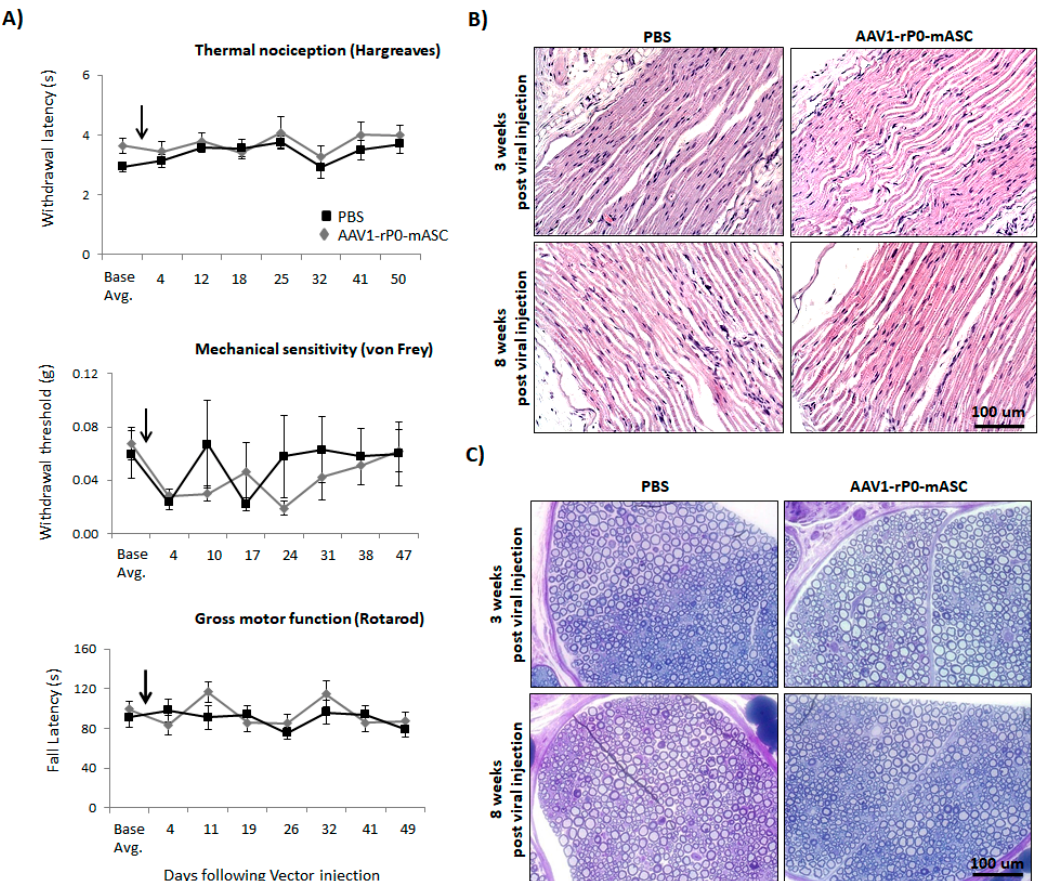
Figure 2. AAV1-rP0-mASC intra-sciatic injection of naïve immunocompetent C57BL/6 mice has no effect on sensory or gross motor function in vivo. ( A ) Effects of intrasciatic AAV1-rP0-mASC or PBS injection on pain behaviors, both thermal (Hargreaves test, top ) and mechanical sensitivity (von Frey method, middle ), and on gross motor function (rotarod, bottom ) were evaluated at 2- to 7-day intervals for approximately 7-weeks following vector/PBS injection (arrows show time of intrasciatic injection). Repeated measures ANOVA was used to (1) compare behaviors of the AAV1-rP0-mASC and PBS injected mice, as well as (2) to conduct within group comparisons post virus injection at each time point to their respective baseline value. Results are represented as the mean ± SEM; n = 8 mice per group. ( B , C ) Neuropathological evaluation of sciatic nerve after AAV1-rP0-mASC or PBS injection; ( B ) hematoxylin and eosin and ( C ) toluidine blue staining of myelin in Epon-embedded sciatic nerve of naïve C57BL/6 mice. Cross sections of sciatic nerve collected 3- and 8-weeks